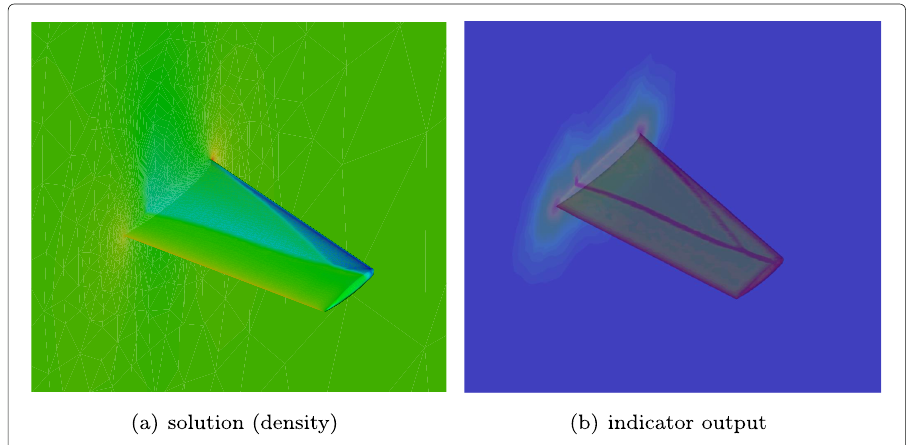
Fig. 11 Solution (density) and indicator in M6 wing test case with Ma = 0.84, α = 3.06 ◦ in the 3D Euler equations